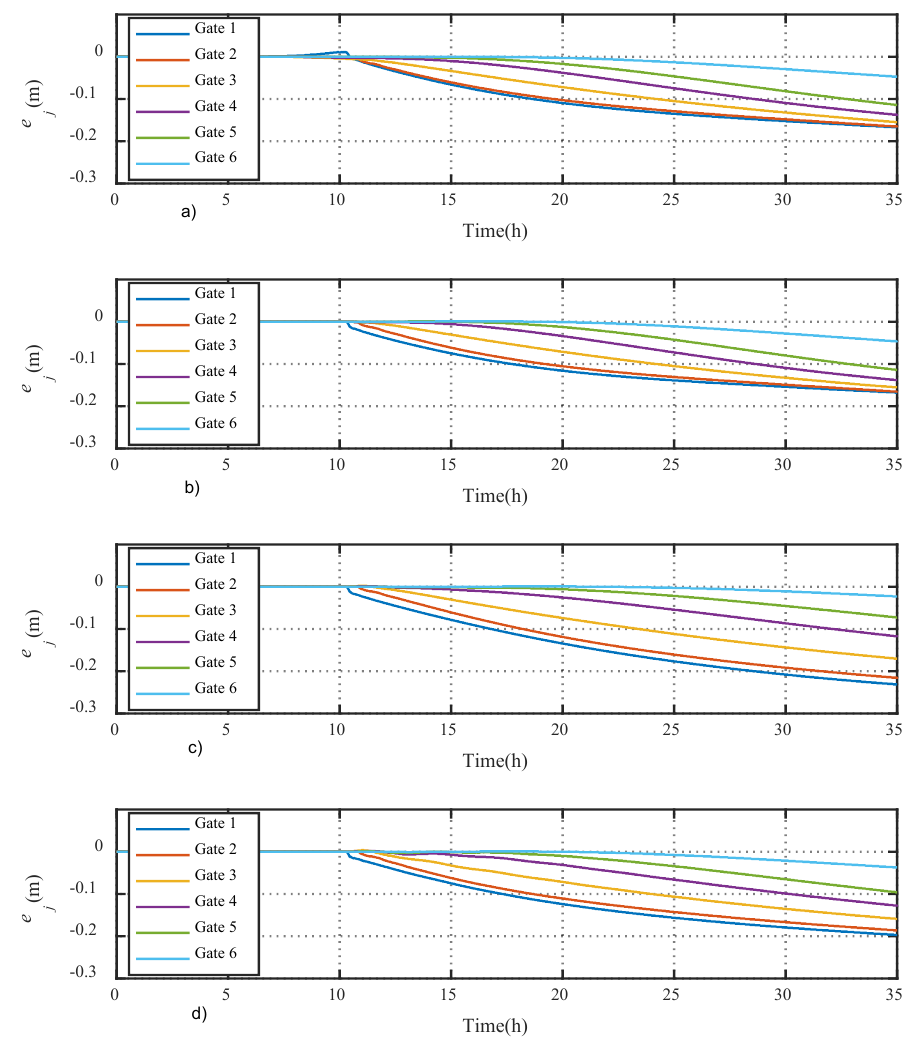
Figure 6. The simulation water level deviation result for scenario No. 3 with MPC-I control ( a ), MPC-I control ( b ), LQR I ( c ), and LQR II ( d ).